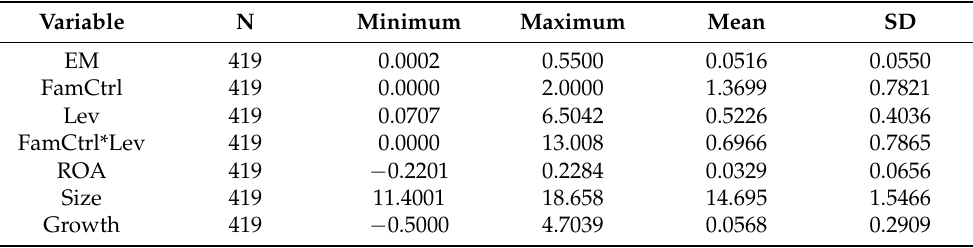
Table 1. Descriptive